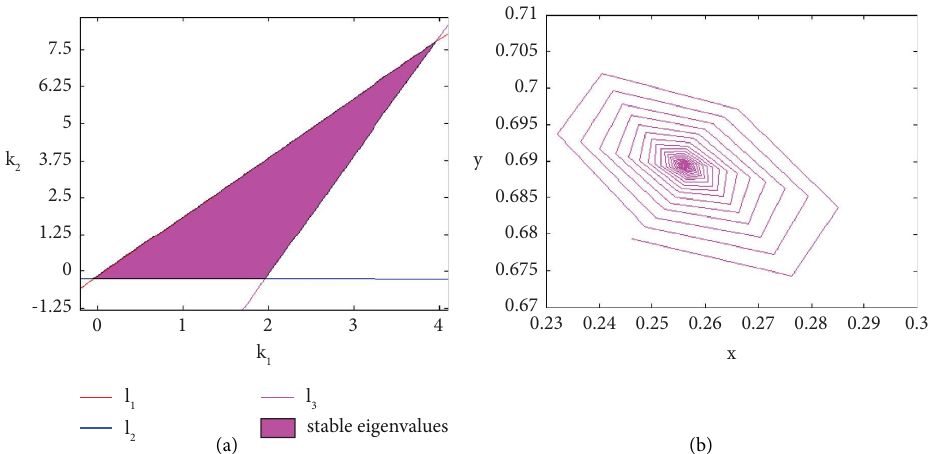
Figure 10: Chaos control in system (15): (a) stability region in ( k